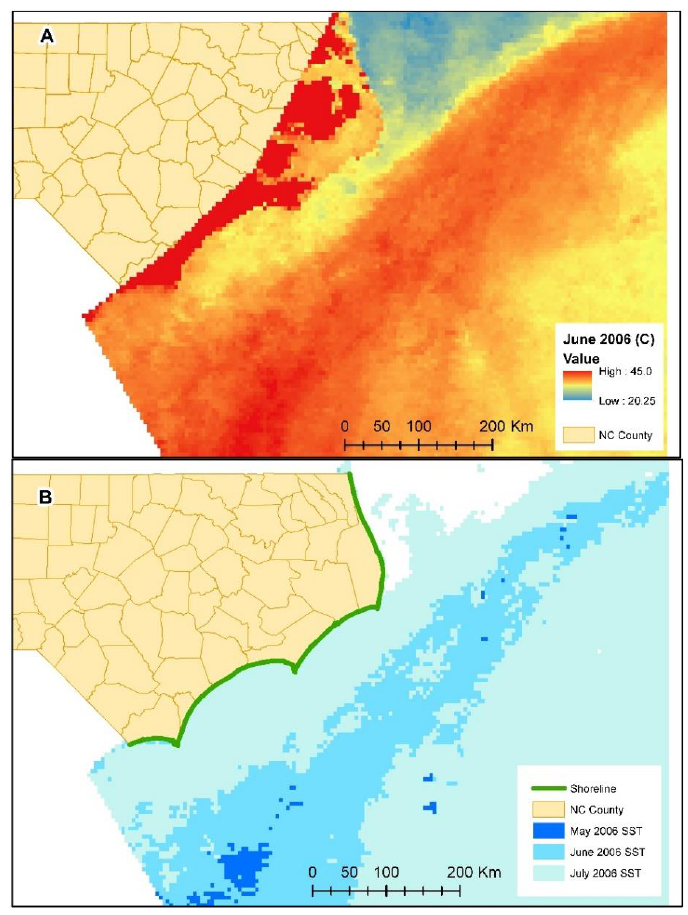
Figure 3. Example Sea Surface Temperature data for June 2016 (A) and preferred temperature zones for Loggerhead sea turtles for May, June and July 2006 (B).